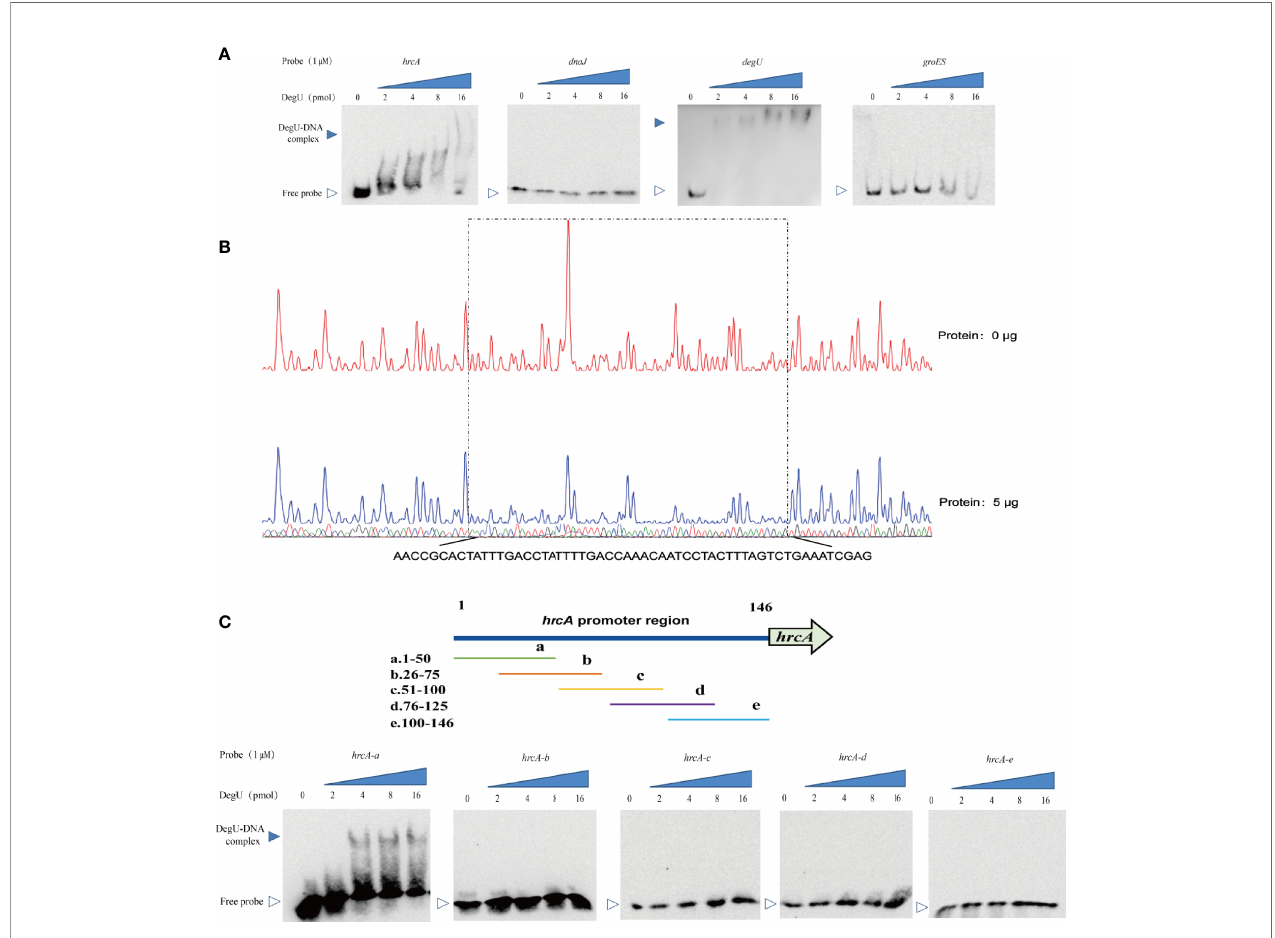
FIGURE 3 | Identi fi cation of DegU binding sites in the hrcA promoter. (A) Electrophoretic mobility shift assay (EMSA) analysis of the direct binding of DegU-P to the hrcA , dnaJ , degU (positive control), and groES (negative control) promoter regions. (B) DNase I footprinting assay analysis of DegU-P binding to the hrcA promoter. FAM-labeled hrcA probes (300 ng) were used for the binding reactions in the absence (upper panel) or presence of 5 µg (lower panel) of DegU. The nucleotide sequences protected by DegU binding are shown below the electropherogram. (C) Electrophoretic mobility shift assay (EMSA) analysis of the binding of DegU-P to various truncated forms of the hrcA promoter. A total of six probes (left panel) were used to identify the DegU binding site in the hrcA promoter region by EMSA (right panel). Each experiment was performed three times, and the representative results were shown.